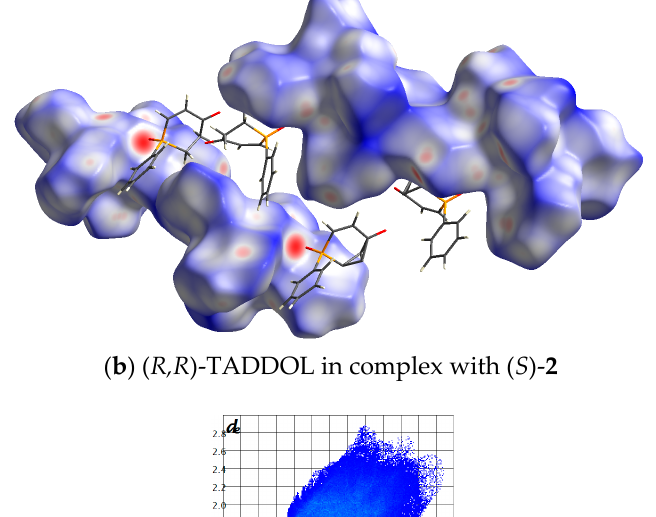
Figure 9. Fingerprints for intermolecular contacts involving enantiomeric ( R )- 2 and (S)- 2 molecules. The Hirshfeld surfaces calculated for ( R,R )-TADDOL (Figure 10) indicate that the hydroxyl group is a part of the O-H...O synthon.